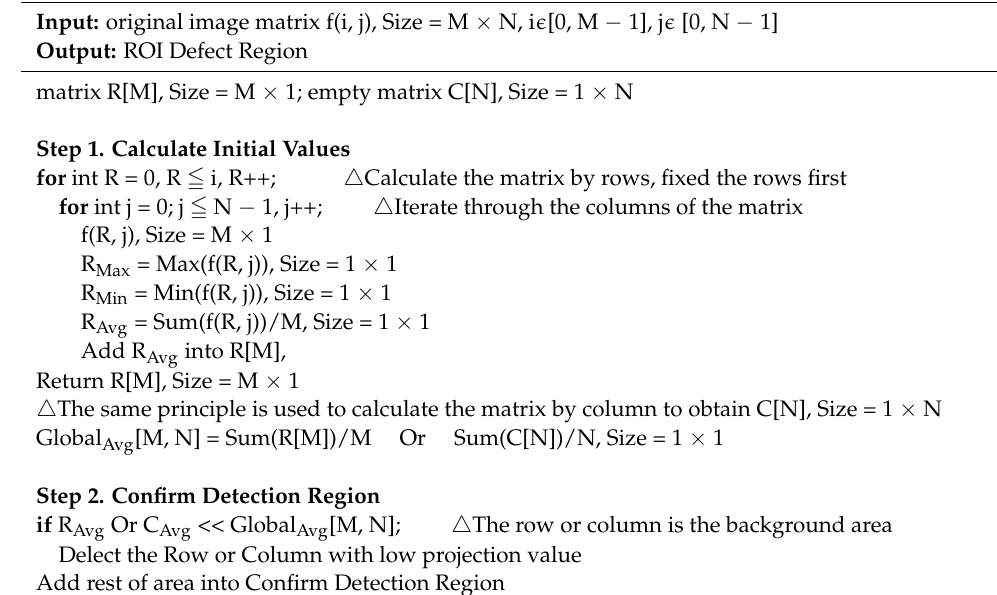
Algorithm 1 Rapid Quality Screening and Defect Feature Extraction